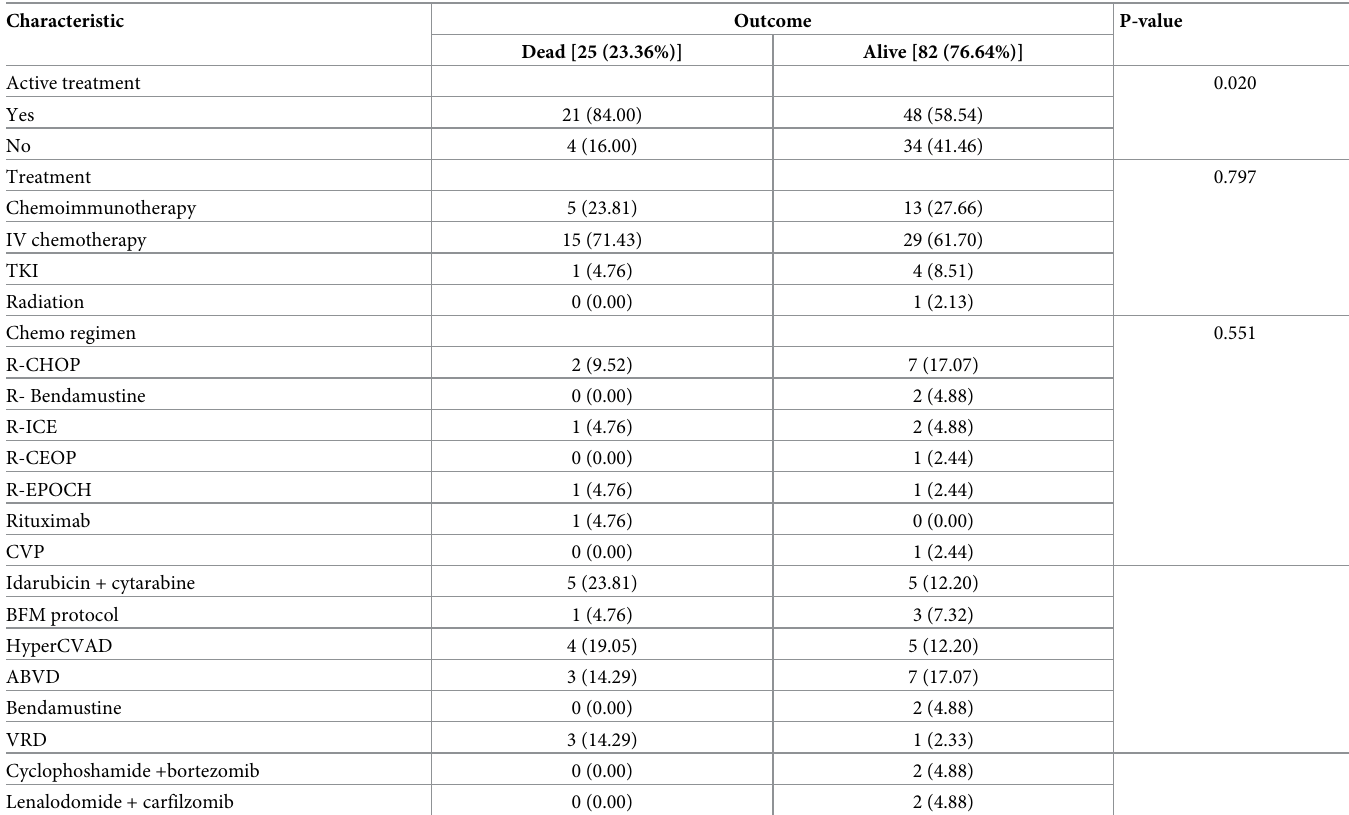
Table 2. Treatment and management of patients with hematological malignancies and COVID-19 stratified on outcome (n = 107). Characteristic